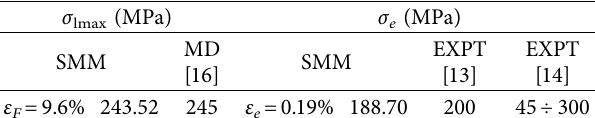
� f F ( f ( ε F ) max ), σ 1max , ε e , and σ e for Au at